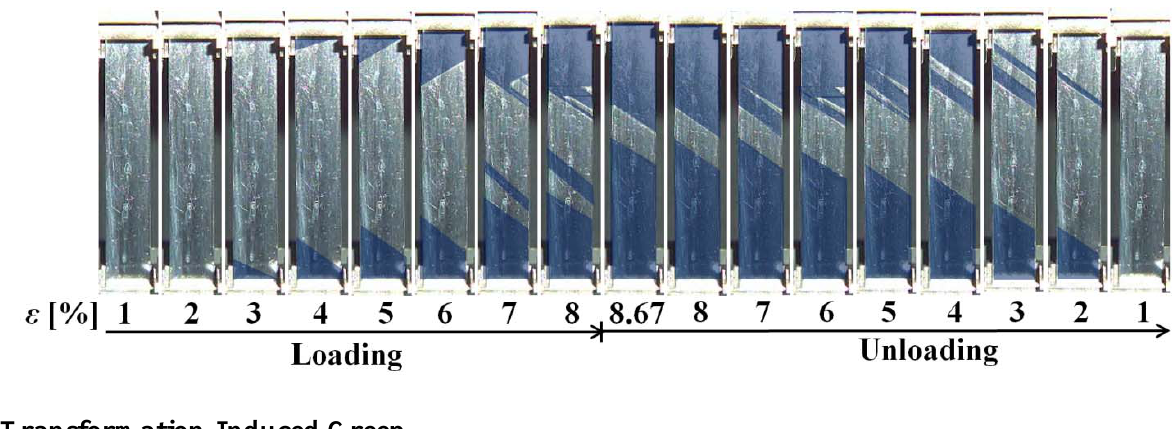
Figure 4. Photographs of specimen surface at various strains ε under stress rate of 0.5